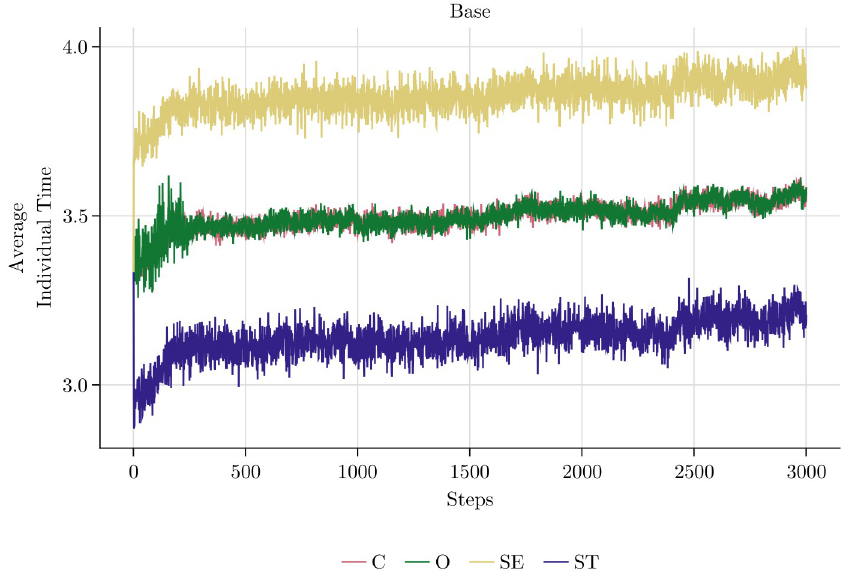
Fig 11. Effect of lower variability on O-agents’